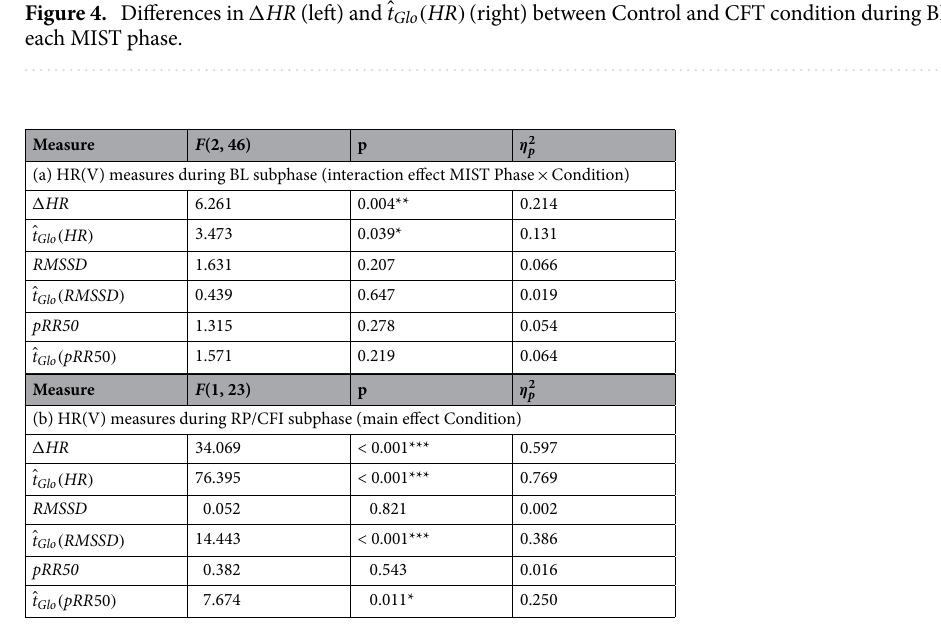
Table 4. Mixed-ANOVA results of HR(V) measures.